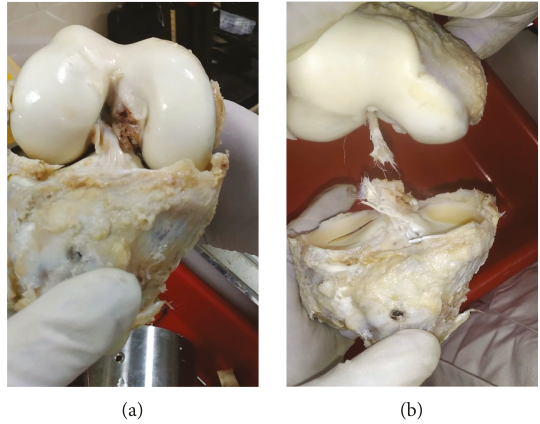
Figure 1: (a) ACL of a cadaver knee shown connecting the femur to the tibia. (b) A torn